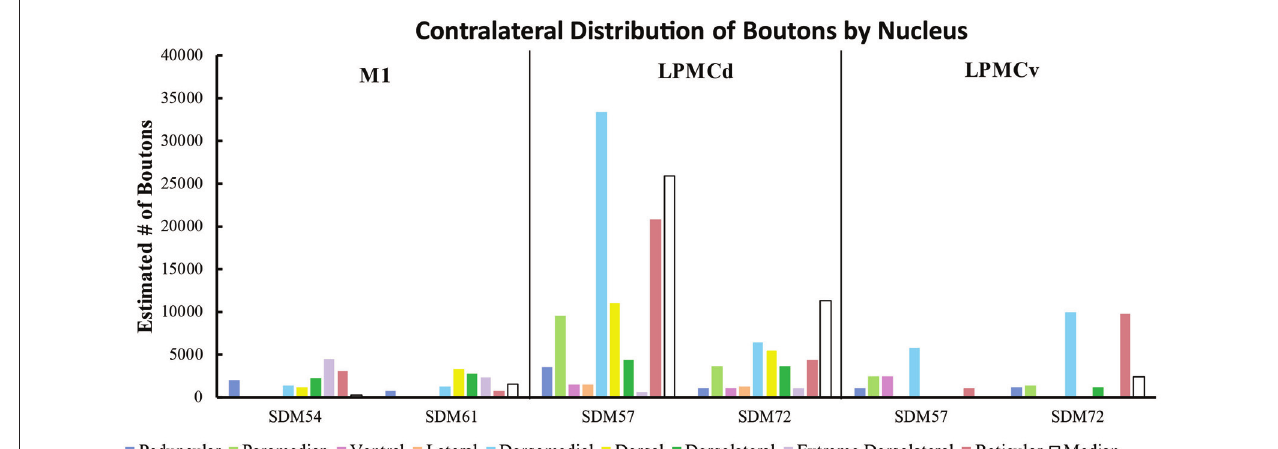
FIGURE 9 | Estimated number of contralateral corticopontine boutons within each pontine nucleus for each injection site in M1, LPMCd and LPMCv in each experimental case.